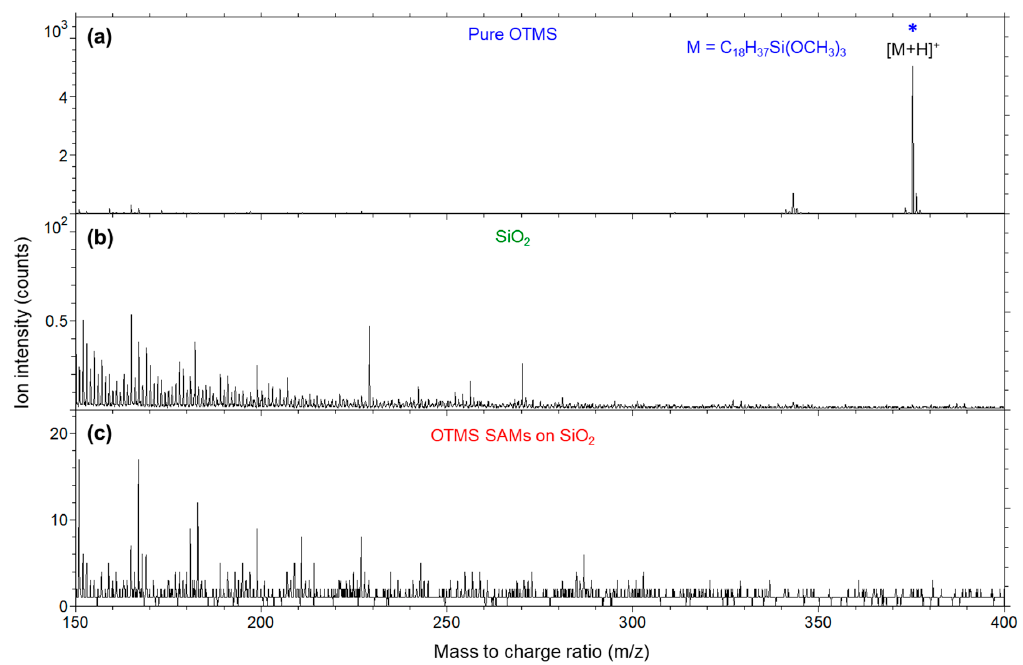
Figure 8. Positive secondary ion mass spectra ( m / z 150 ‒ 400) for ( a ) pure OTMS (placed on a polypropylene film); ( b ) a UV/ozone-treated SiO 2 surface; ( c ) OTMS SAMs prepared on a UV/ozone- treated SiO 2 substrate. Ions indicated by a star (*) are associated with the OTMS headgroup, ‒Si(OCH 3 ) 3 .